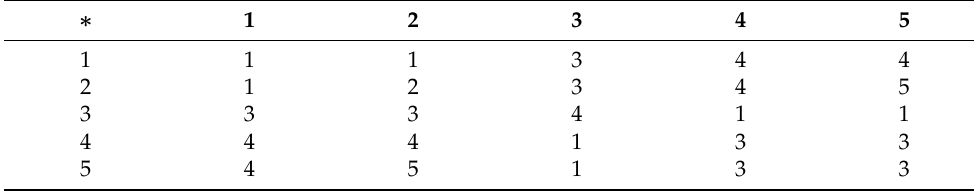
Table 10. A quasi-cancellative T2CA-groupoid of Example 10.